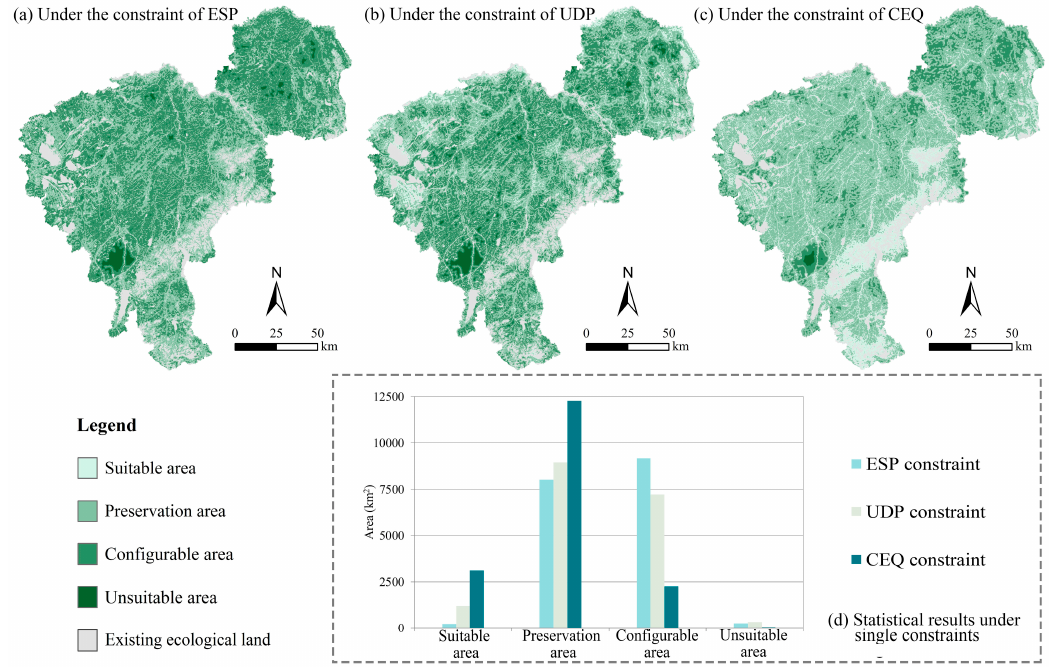
Figure 5. Ecological land reoccupation pattern under the single constraints of ( a ) the ESP; ( b ) the UDP; ( c ) the CEQ; and ( d ) the statistical results.